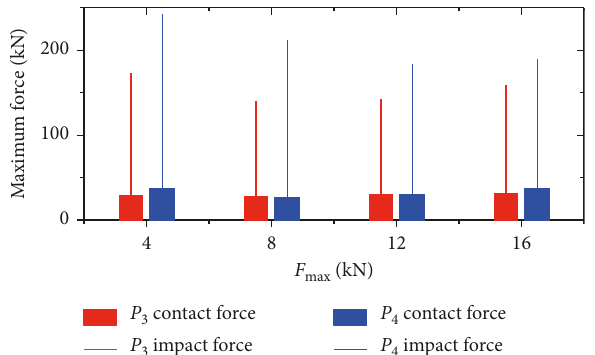
Figure 14: Maximum contact and impact force in P